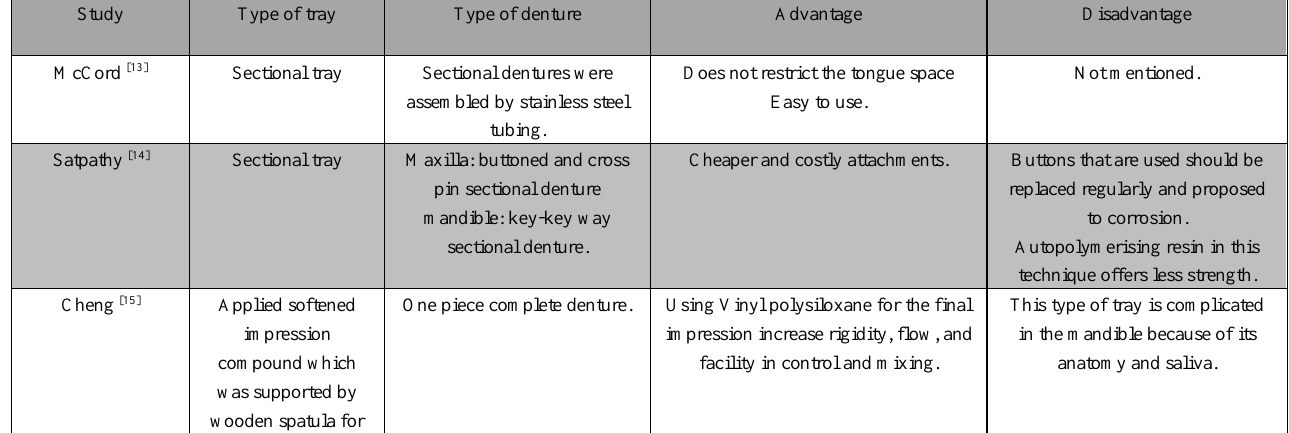
Table 2. some considerations of preparing dentures for Microstomia